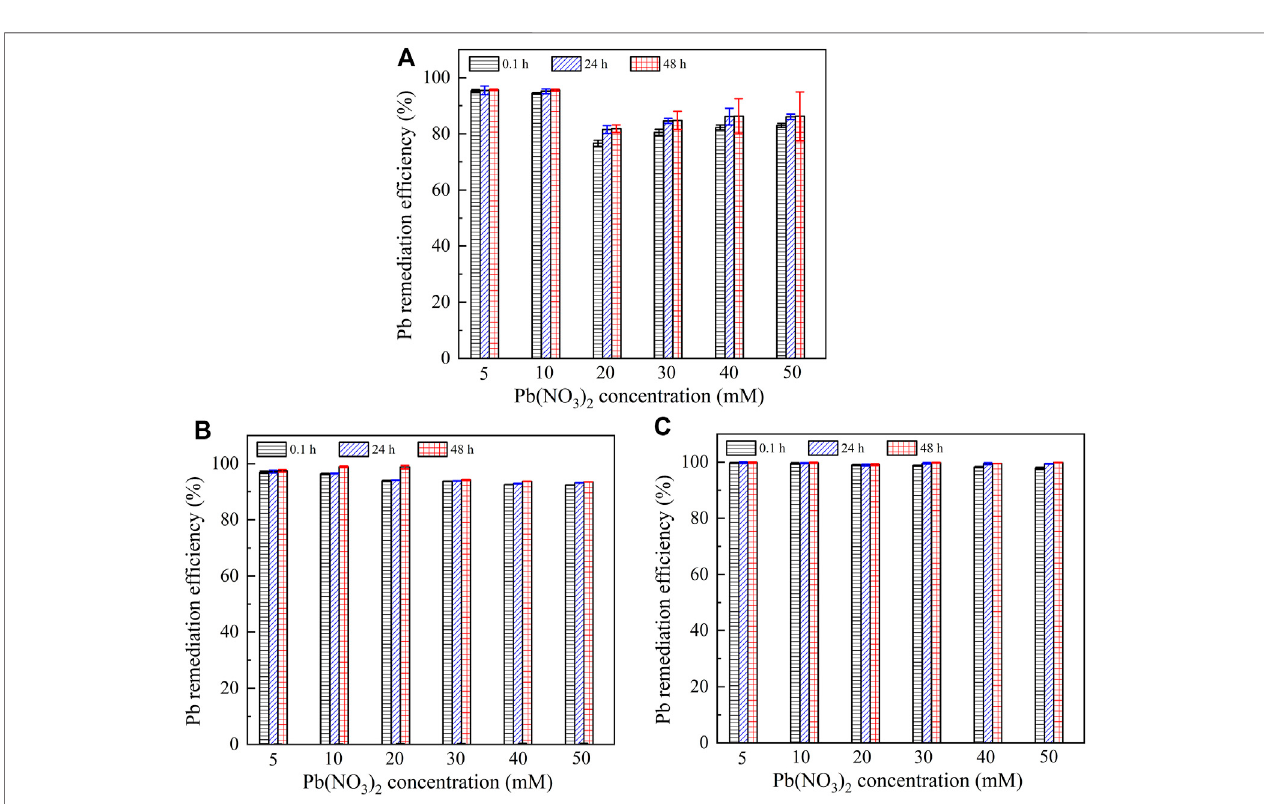
FIGURE 7 | Relationship of remaining Pb 2+ concentration and Pb remediation ef fi ciency versus Pb(NO 3 ) 2 concentration: (A) without yeast extract and CaCl 2 , (B) with yeast extract, and (C) with yeast extract and CaCl 2 .